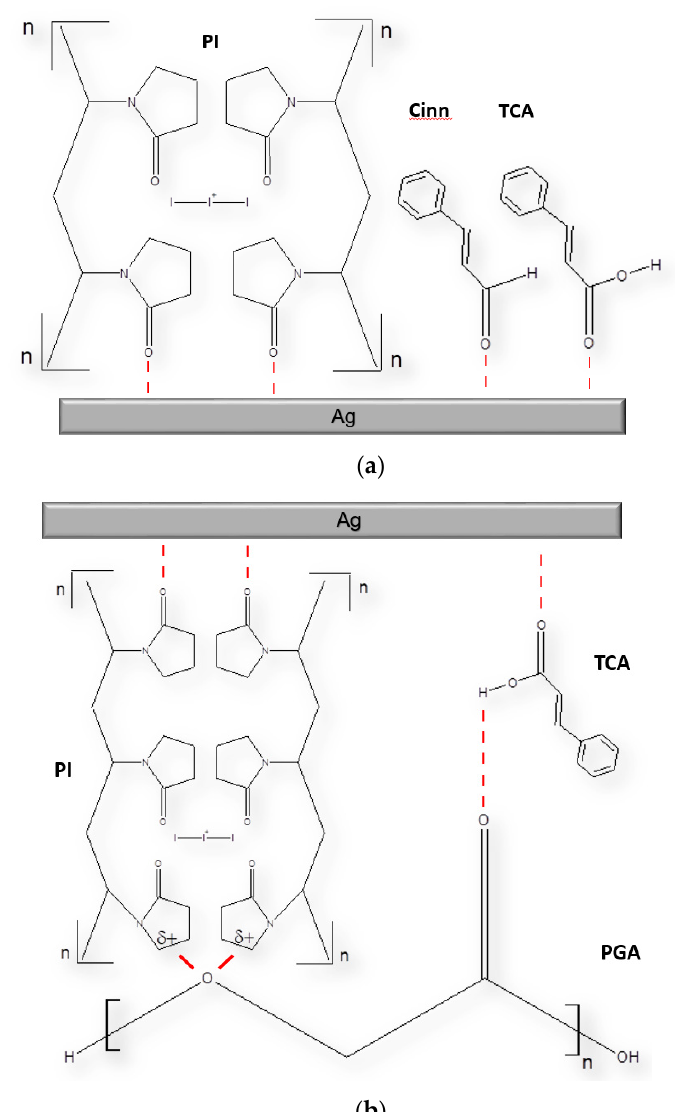
Figure 10. Scheme of physical adsorption in four samples on AgNP. From left to right: ( a ) TCA, Cinn and PI; ( b ) TCA, PI on PGA suture. Cinn and PI; ( b ) TCA, PI on PGA